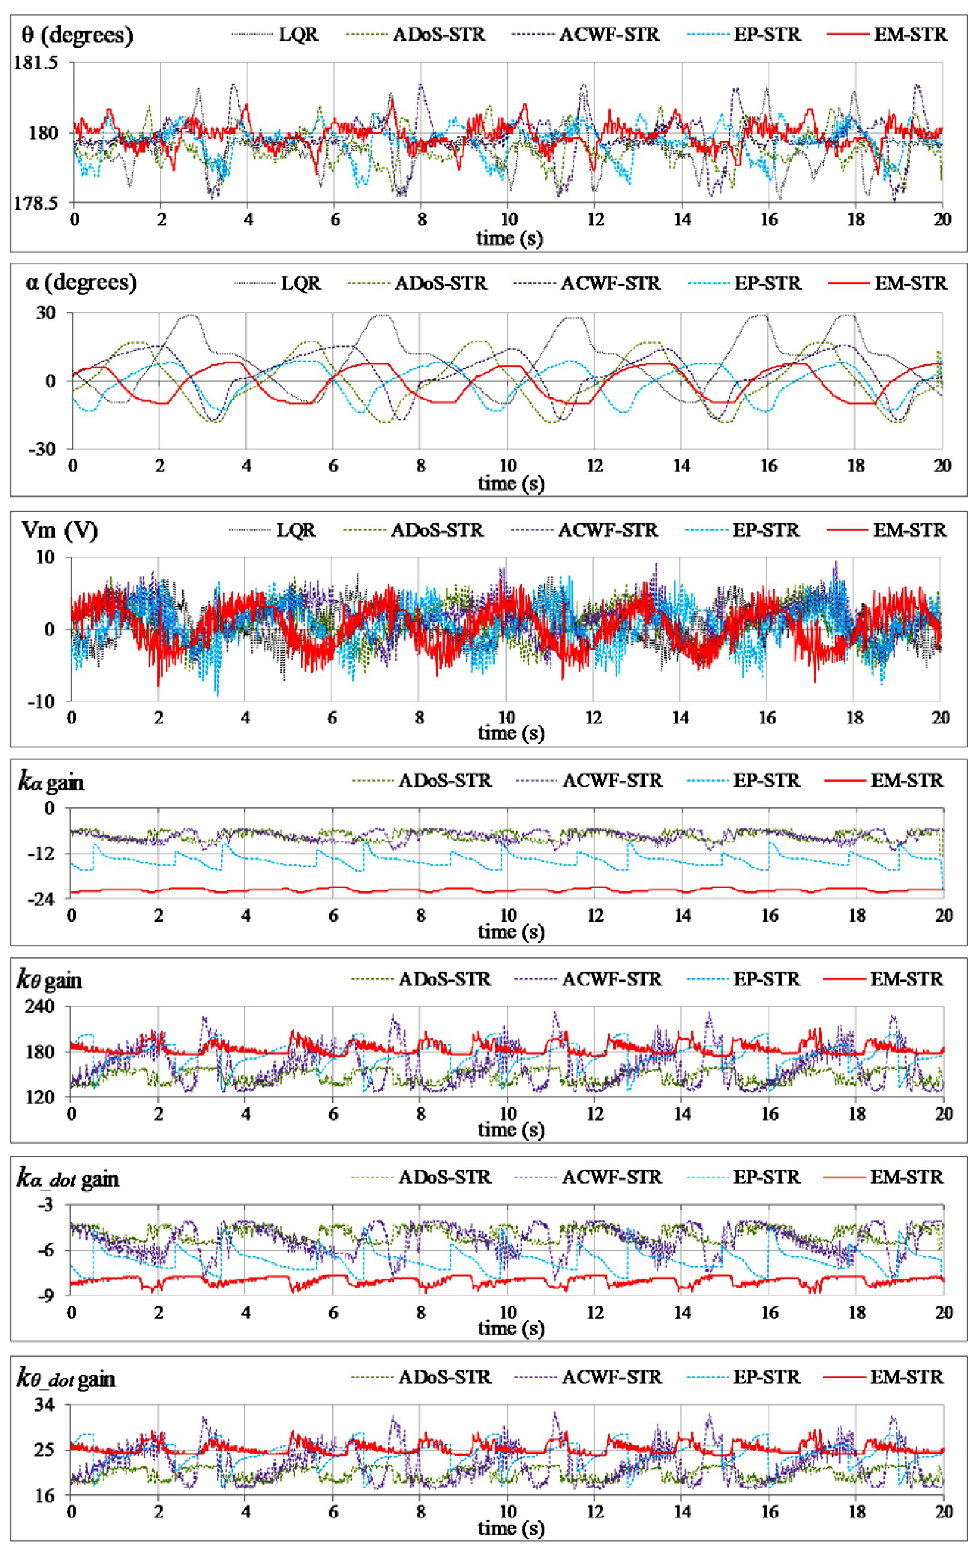
Fig 12. Pendulum’s response under normal conditions.